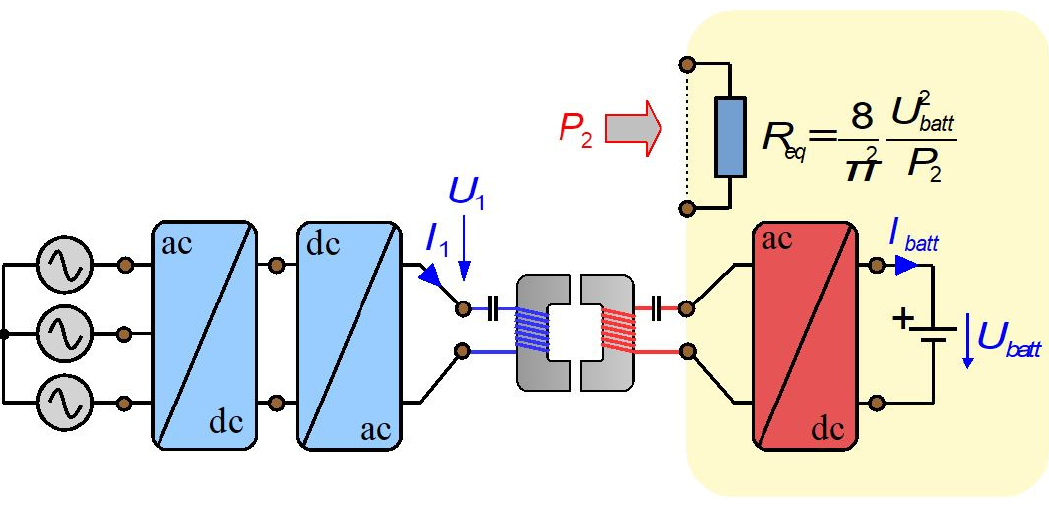
Figure 4. Typical WPT system